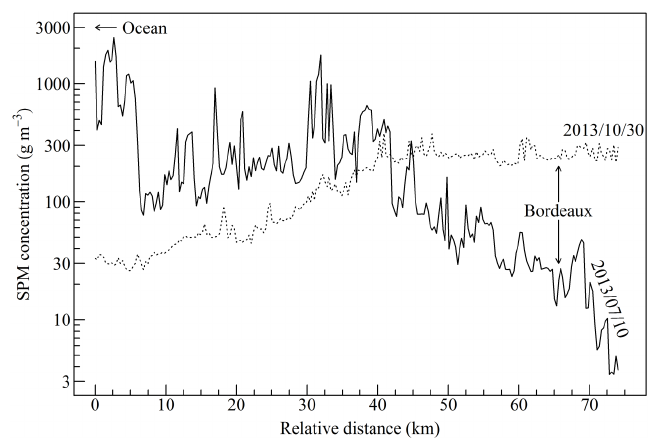
Figure 7. Landsat8-derived longitudinal transect of suspended particulate matter (SPM) surface concentration in the Gironde estuary on 10 July 2013 (solid line) and 30 October 2013 (dotted